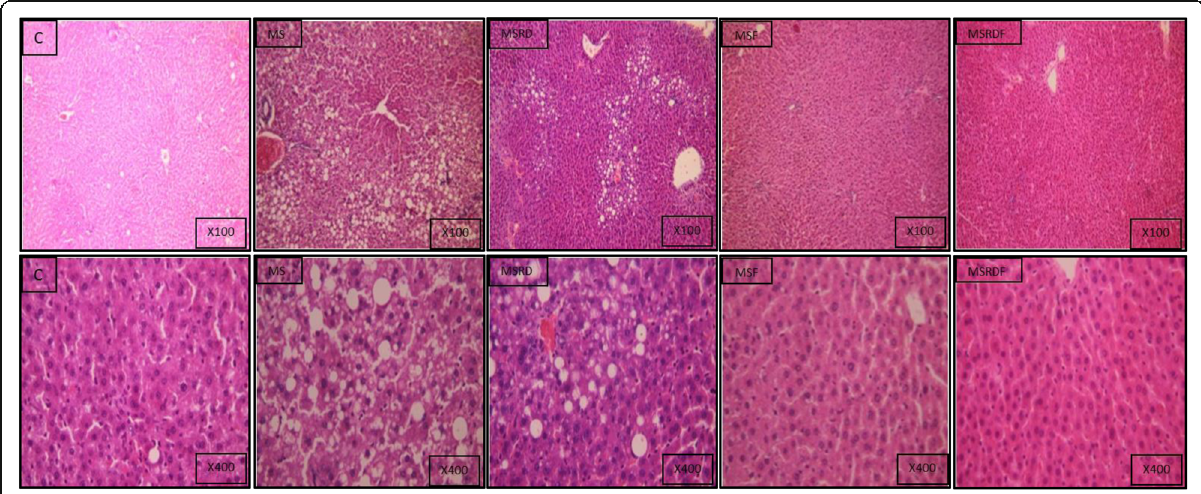
Fig. 8 Liver tissue photomicrograph of the five study groups after 12 weeks (H&E). C control group, MS untreated metabolic syndrome group, MSRD metabolic syndrome group reverted to regular rat chow, MSF metabolic syndrome group on alternate day fasting, MSRDF metabolic syndrome group reverted to regular rat chow and on alternate day fasting